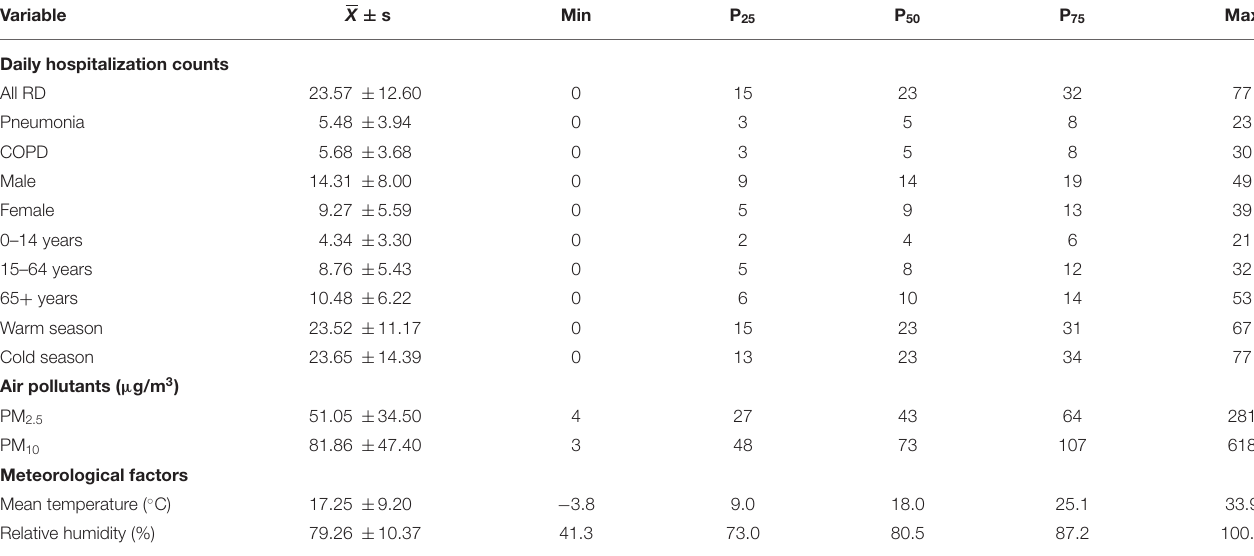
TABLE 1 | Descriptive statistics of daily hospitalization counts of RD, air pollutant concentration, and meteorological factors in Wuhan, China, 2015–2020. Variable